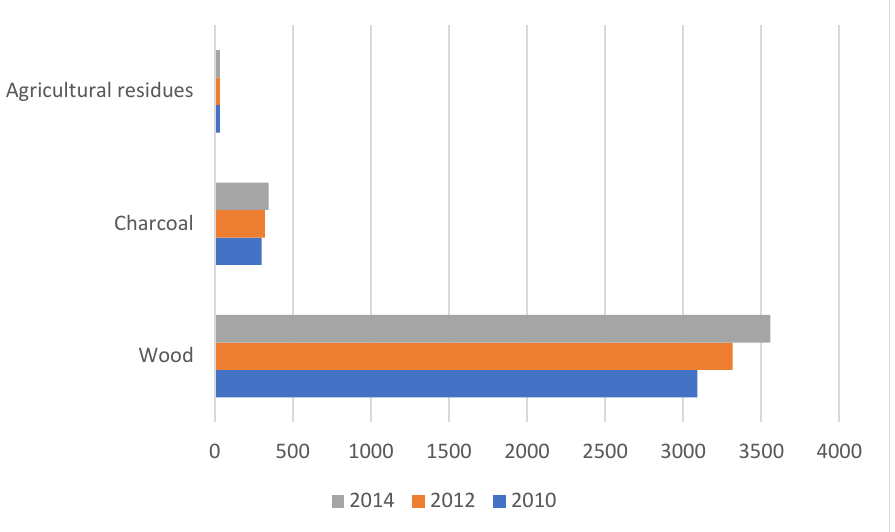
Figure 2. Biomass production. Using data from [62].